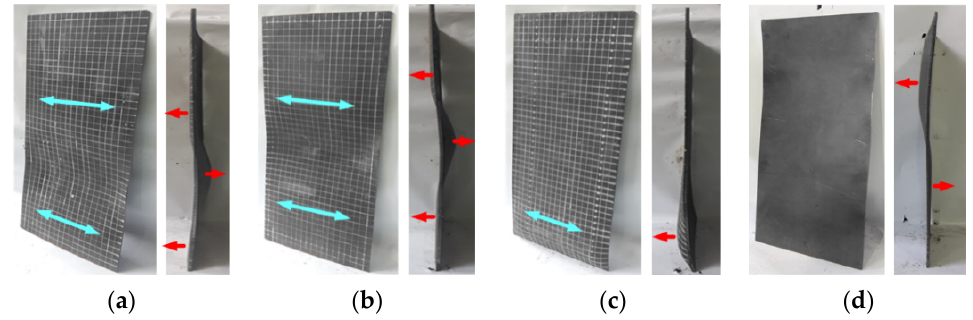
Figure 7. Collapse mode of curved plates after testing (a/b = 2.0, t = 6 mm): ( a ) C01, ( b ) C02, ( c ) C03, and ( d ) F01.